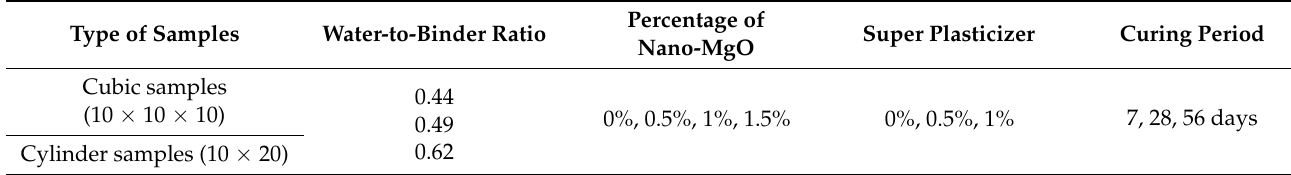
Table 5. Properties and variables of experimental samples.